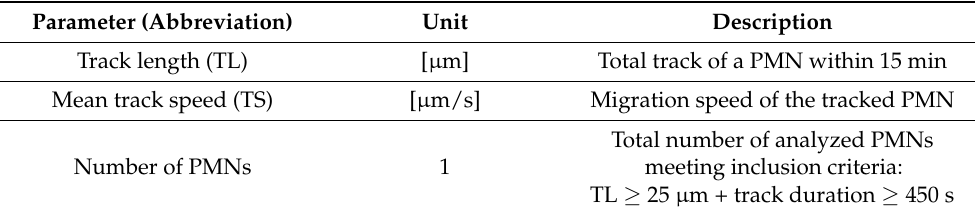
Table 8. Analyzed parameters as indicators of the migration properties of PMNs, defined according to